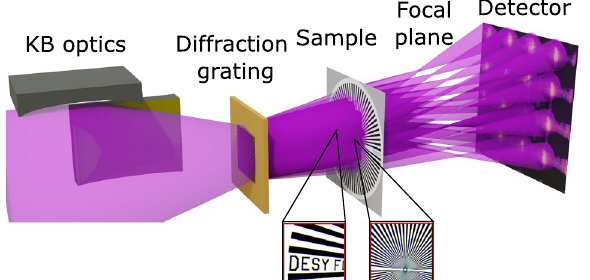
Figure 2. Schematic of the experimental setup. The FEL beam was focused 9 cm after the sample using bendable KB mirrors. The beam-splitting 2D diffraction grating was placed 210 cm after the center of the last KB mirror. The sample was placed approximately 0.9 cm behind the grating and thus illuminated by the overlapping beamlets produced by the grating. The two areas of the Siemens star sample ‘letters’ and ‘stripes’ are shown in the insets. The ANDOR iKon-M SO CCD was placed in the intermediate field 66 cm downstream of the sample. Alternatively, the PERCIVAL detector was placed in the intermediate field 135 cm downstream of the sample.